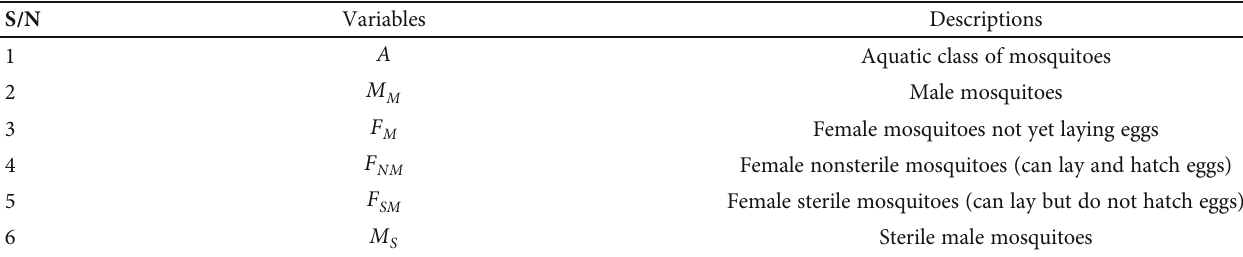
Table 1: Model variables and descriptions.